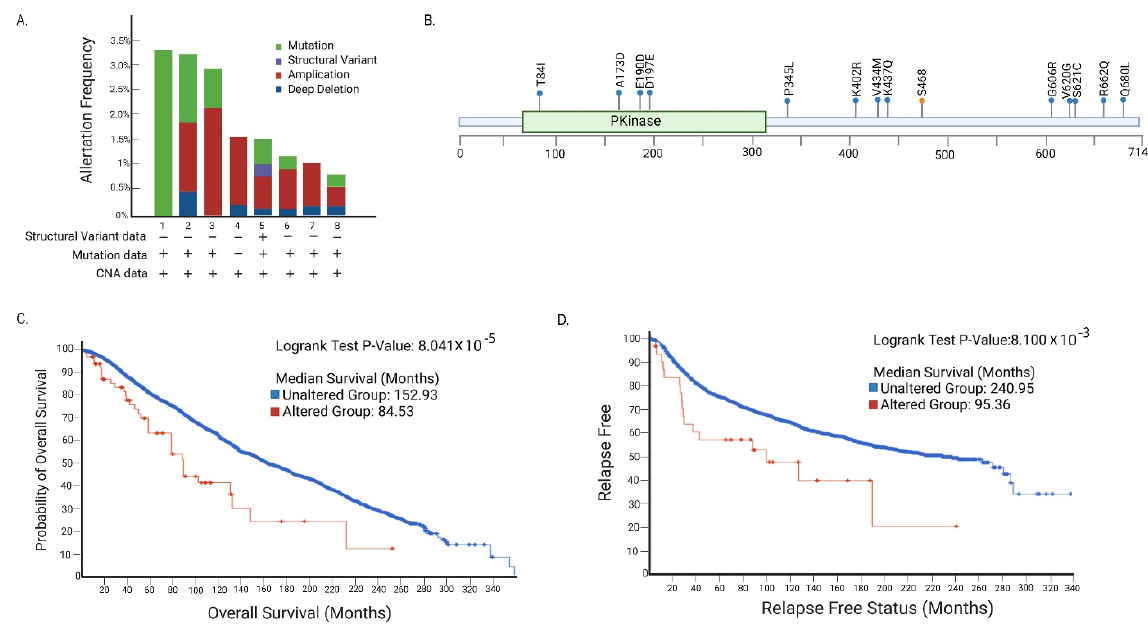
Figure 1. HUNK alteration in cBioPortal breast cancer datasets. ( A ) HUNK appeared in 8 of 24 studies and has an alteration frequency of up to 3% (1: Proteogenomic landscape of breast cancer (CPTAC), 2: Metastatic Breast Cancer (INSERM), 3: The Metastatic Breast Cancer Project, 4: Breast Cancer (METABRIC), 5: Breast Invasive Carcinoma (TCGA, PanCancer Atlas), 6: Breast Invasive Carcinoma (TCGA, Firehose Legacy), 7: Breast Invasive Carcinoma (TCGA), 8: Breast Invasive Car- cinoma (TCGA). ( B ) Specific alterations that are identified in HUNK (each dot represents a single mutation, blue dot = missense mutation, orange dot = nonsense mutation). ( C ) Kaplan–Meier anal- ysis showing patients with alterations in HUNK have poorer outcomes indicated by median time of overall survival, and ( D ) relapse free survival